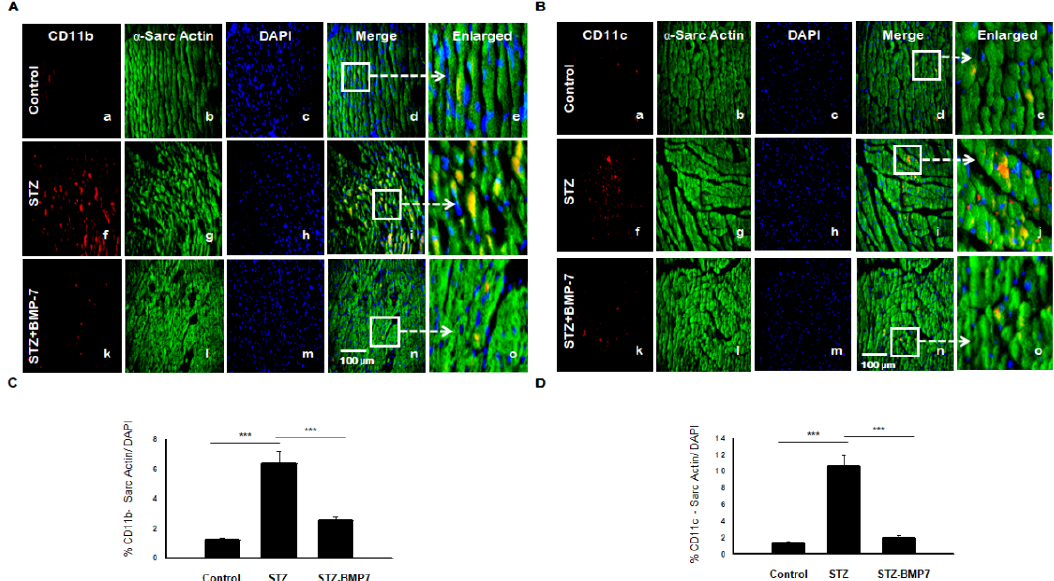
Figure 6. BMP-7 decreases the expression of inflammatory dendritic cells (CD11b and CD11c) in the diabetic cardiac heart. ( A , B ) Representative photomicrographs of heart sections stained in the control group (a–e), STZ group (f–j), and STZ-BMP7 group (k–o) with sarcomeric- α actin (green, stained cardiac myocyte) (b, g, l) and CD11b ( A ) and CD11c ( B ) in red (a, f, k) with nuclei stained (c, h, m) by DAPI in blue, merged (d, i, n) and enlarged (e, j, o) image. ( C , D ) Quantitative analysis-derived histograms of CD11b ( C ) and CD11c ( D ) +ve cardiomyocytes (colocalization of both red and blue DAPI in green cardiomyocyte) were quantified over total DAPI in heart sections of mice. Statistical analysis was performed using One-Way ANOVA, which was followed by the Tukey test. Error bars= mean ± S.E.M., *** p < 0.001; Scale bar = 100 µm; n = 16/group.